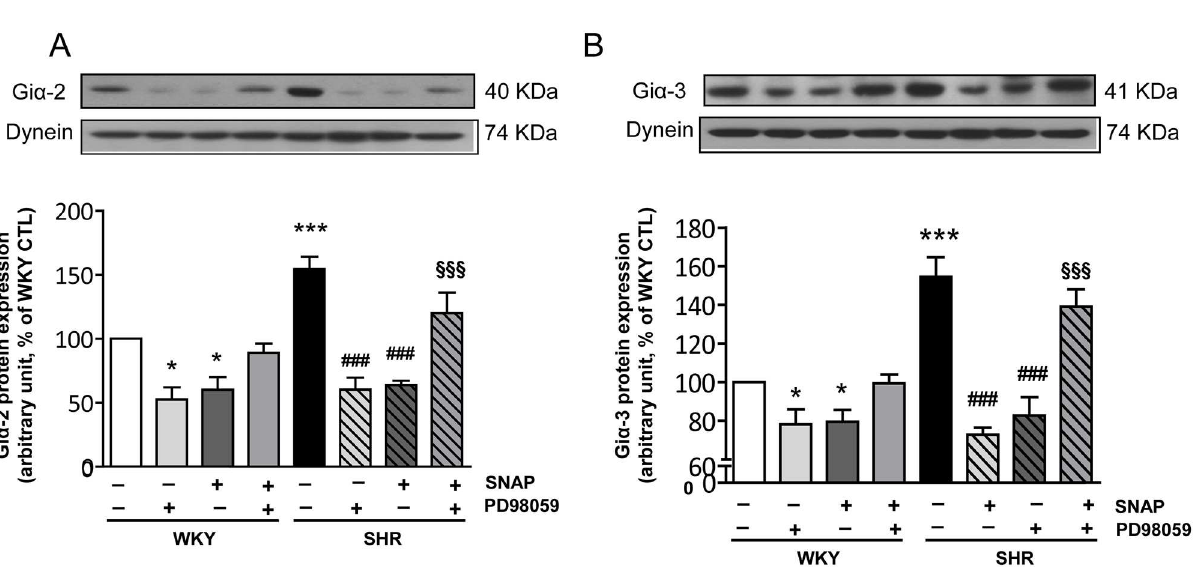
Fig 8. Effects of PD98059in SNAP- induced decreasedexpression of Gi α -2 and Gi α -3 proteins in aortic VSMC from 12-week old SHR and age-matched WKY rats. ConfluentVSMC were incubatedin the absence (control) or presenceof PD98059(10 μ M), for 30 mins prior to the treatment with SNAP for 24 h. The cell lysates were preparedand subjectedto Western blot analysisusing specific antibodies against Gi α -2(A) and Gi α -3 (B) or dynein as loadingcontrol (upper panel) as describedin the Materials and methods. Quantificationof protein bands was done by densitometric scanning(lower panel). The results are expressedas a percentageof the WKY control (CTL), which was taken as 100%. Values are the mean ± SD of 5 separateexperiments using different cell populationsfrom different animals. * P < 0.05, *** P < 0.001vs WKY CTL group; ### P < 0.001 vs SHR CTL group; §§§ P < 0.001vs SHR-SNAP treated group.